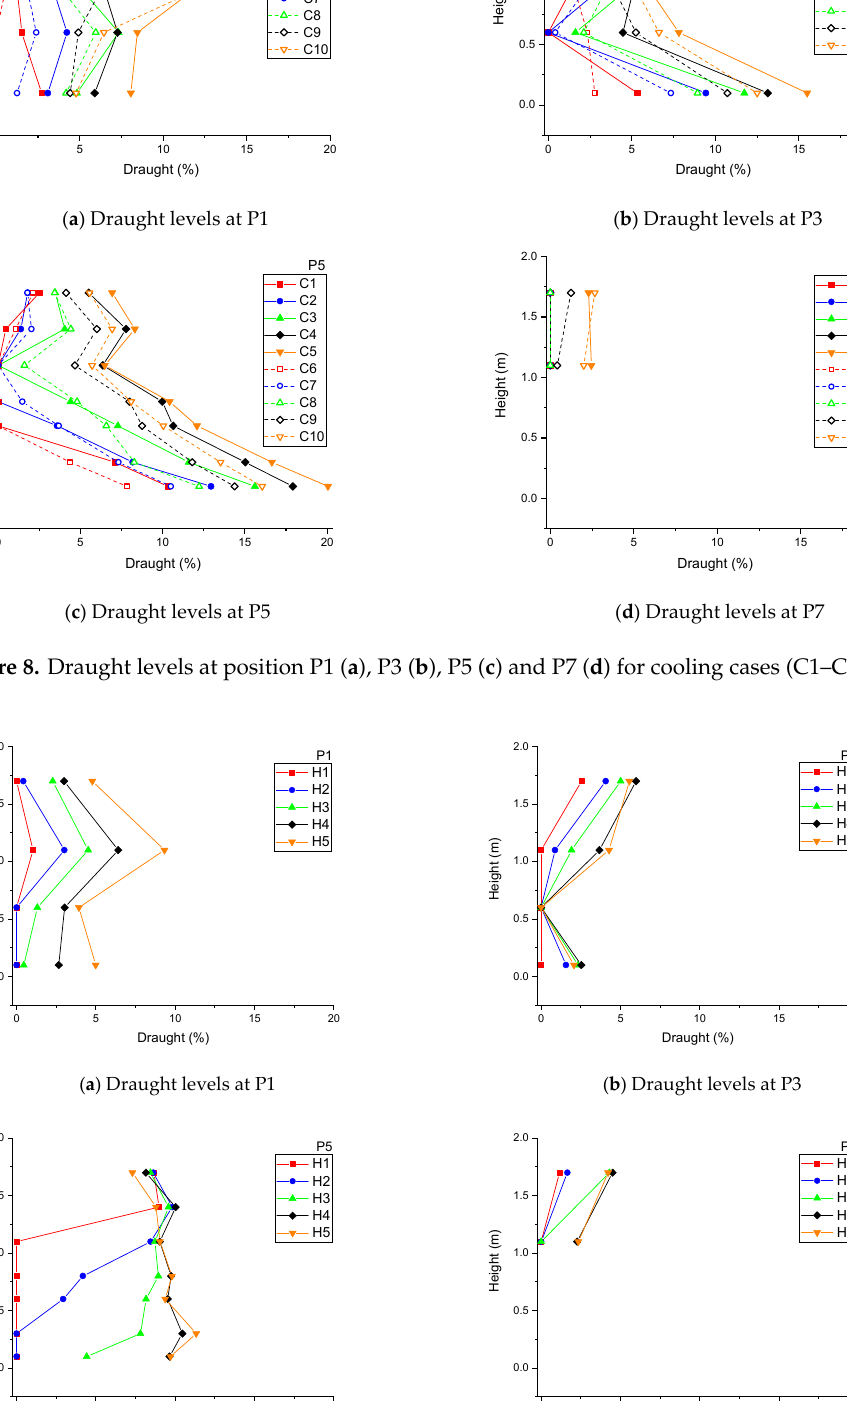
Buildings 2019 , 9 , x FOR PEER REVIEW